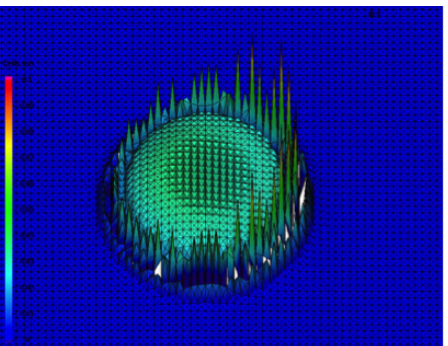
Figure 2. Instabilities at the wave front exposed by an unstable numerical scheme for wave propagation. The spurious peaks in the numerical solution are of the size of the grid cells (shown as triangles). The colors indicate wave height above mean water level. The plot shows one snapshot of a shallow water wave propagation